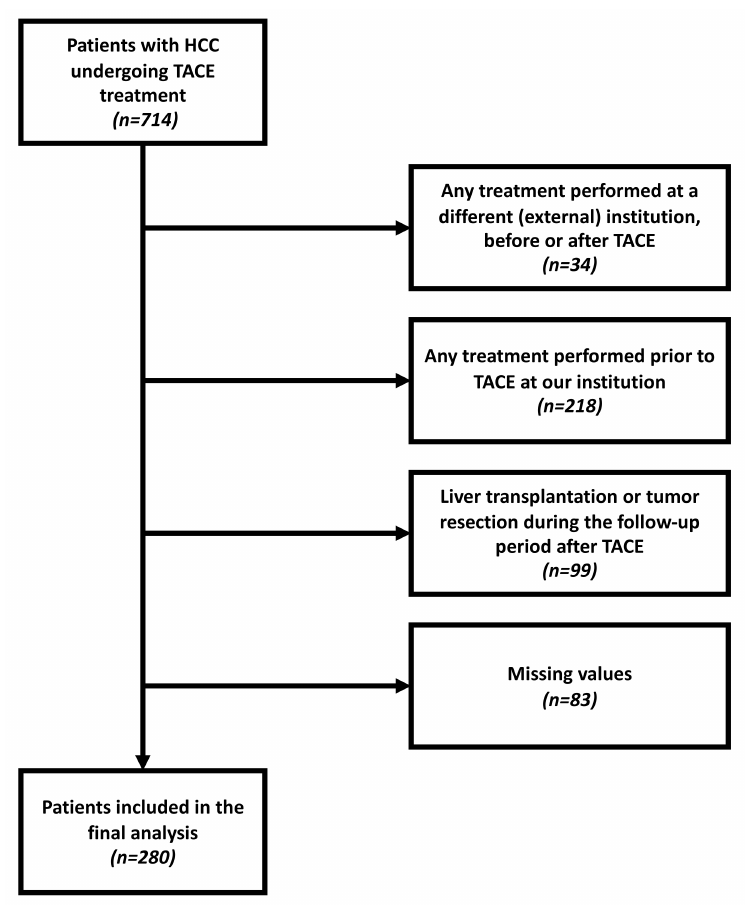
Figure 1. Flowchart showing the various reasons why patients were excluded from this